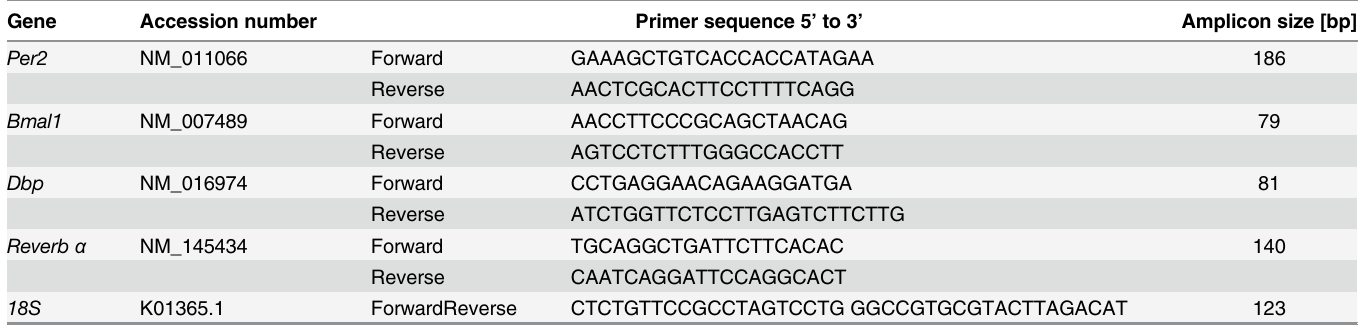
Table 1. PCR primers and